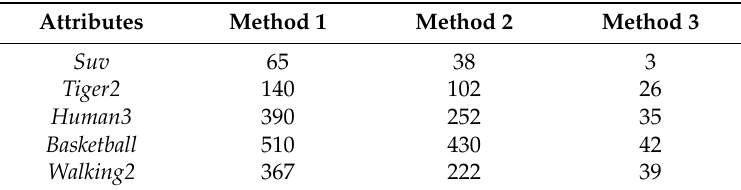
Table 1. Algorithm time-consuming contrast (ms).